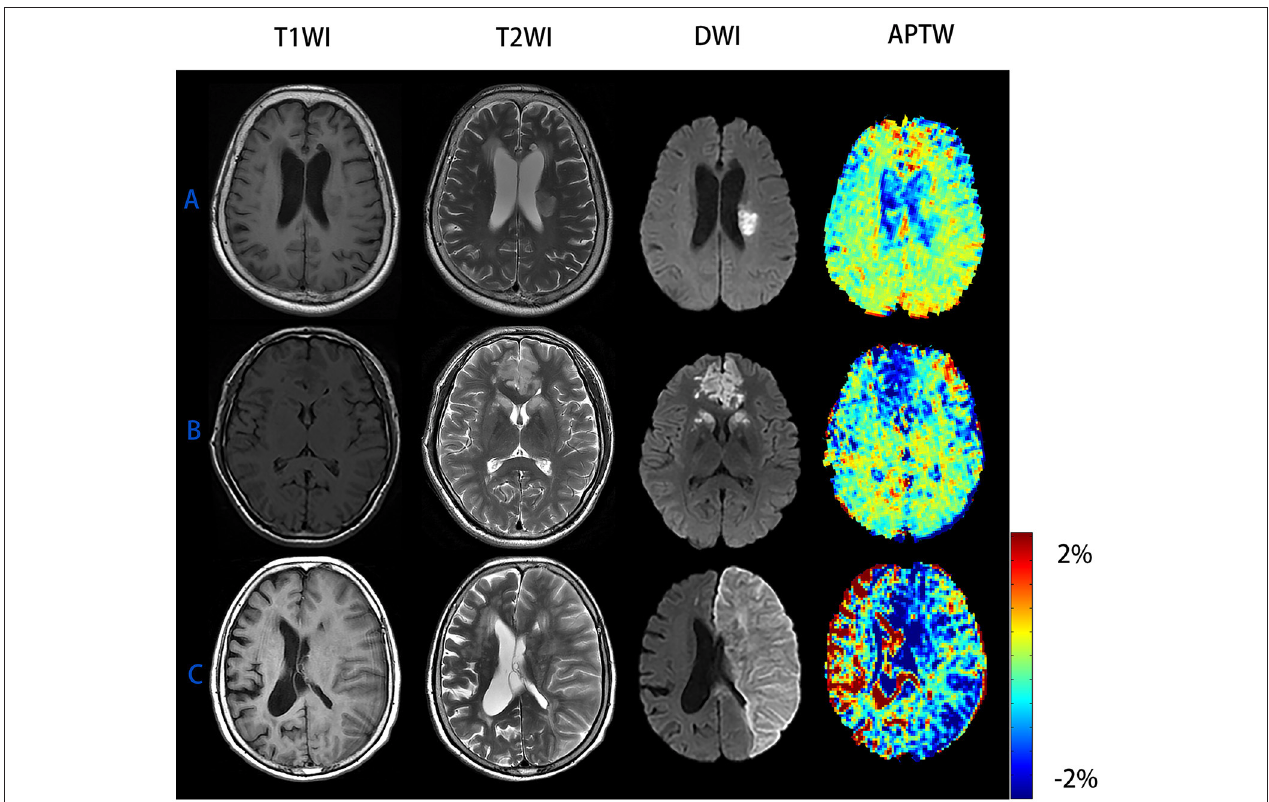
FIGURE 3 | Conventional MR images and APTW images of patient with AIS of different NIHSS scores and mRS scores. (A) M/65 years, NIHSS score was 3 and 90-day mRS score was 0, 1 APTW = − 0.37%. (B) F/69 years, NIHSS score was 5 and 90-day mRS score was 2, 1 APTW = 0.82%. (C) M/81 years, NIHSS score was 22 and 90-day mRS score was 6, 1 APTW = 1.93%. The criterion for patient with good prognosis (mRS score < 2) is 1 APTW > −